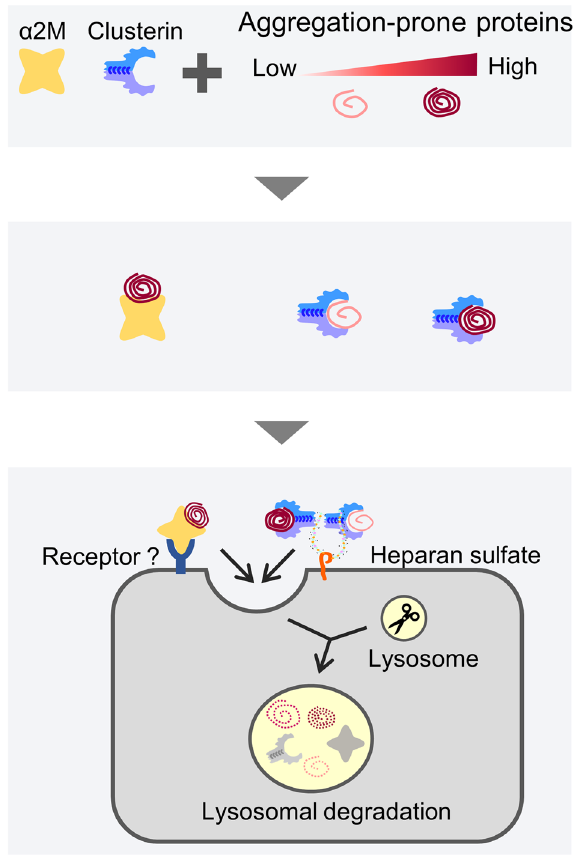
Figure 7. Model of the extracellular misfolded protein degradation pathway by extracellular chaperones. Clusterin targets a broad range of misfolded proteins than α 2 M. The binding kinetics of the extracellular chaperone might be one determinant of the substrate recognition of an extracellular chaperone. The α 2 M– misfolded protein complex is internalized via a putative receptor, leading to degradation of the α 2 M–misfolded protein